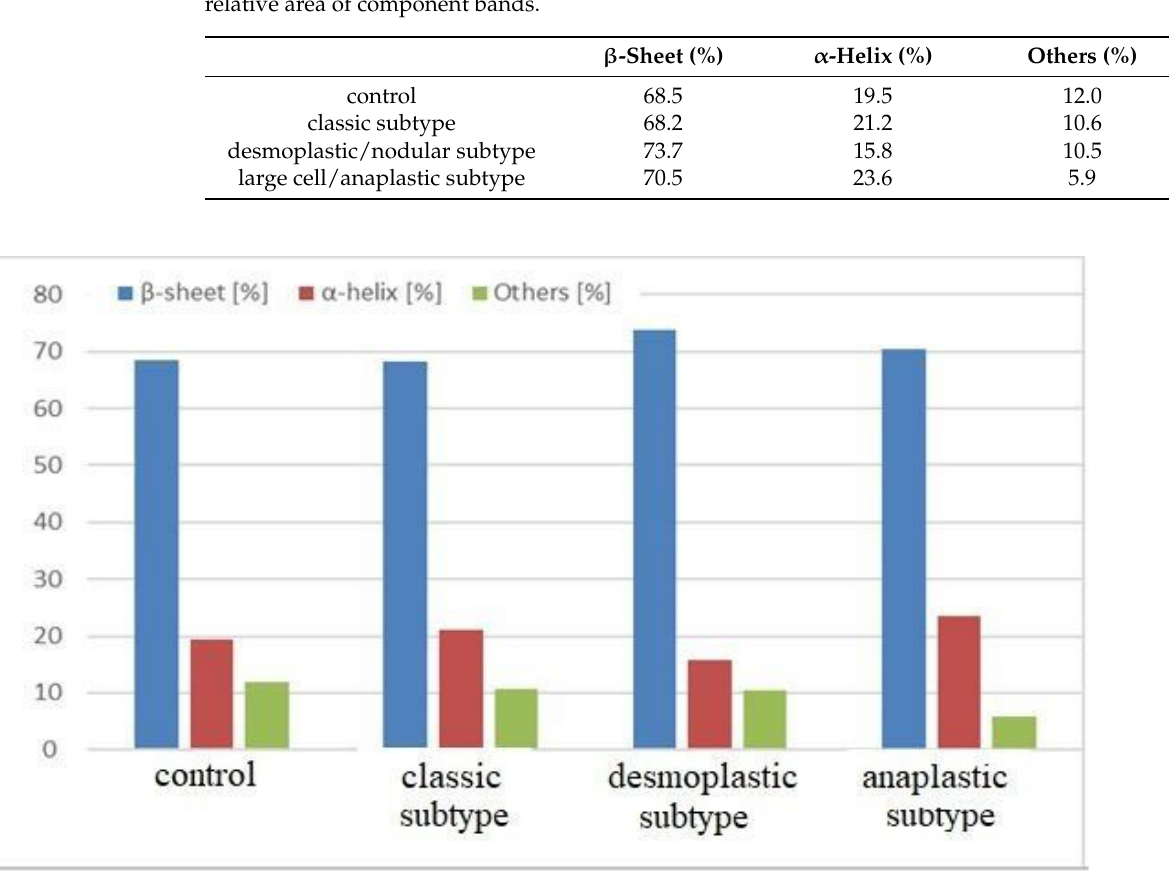
Figure 4. Protein secondary structure composition (%) of control and MB histological subtypes: classic, desmoplastic/nodular, and large cell/anaplastic.